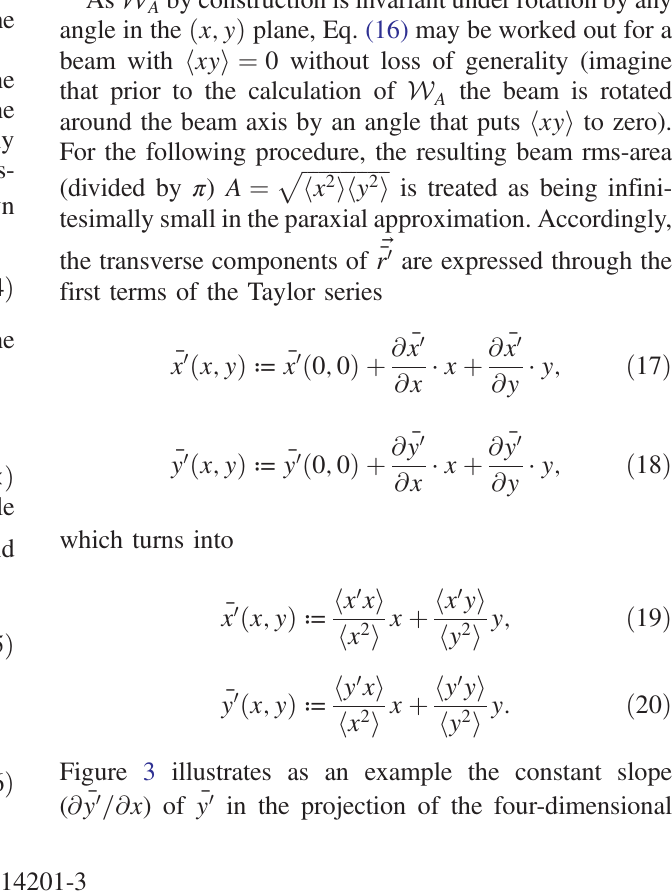
FIG. 3. Projection of the four-dimensional rms-ellipsoid onto the ð x; y 0 Þ plane and the constant slope ( ∂